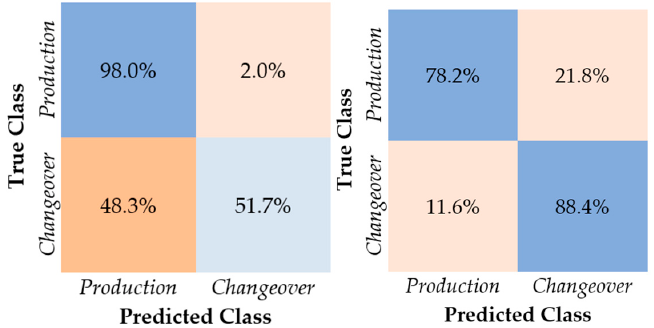
Figure 5. Confusion Matrix of Fine Tree Algorithm (True Positive Rates, False Negative Rates) ( left ) Confusion Matrix of RUSBoosted Tree Algorithm (True Positive Rates, False Negative Rates) ( right ).